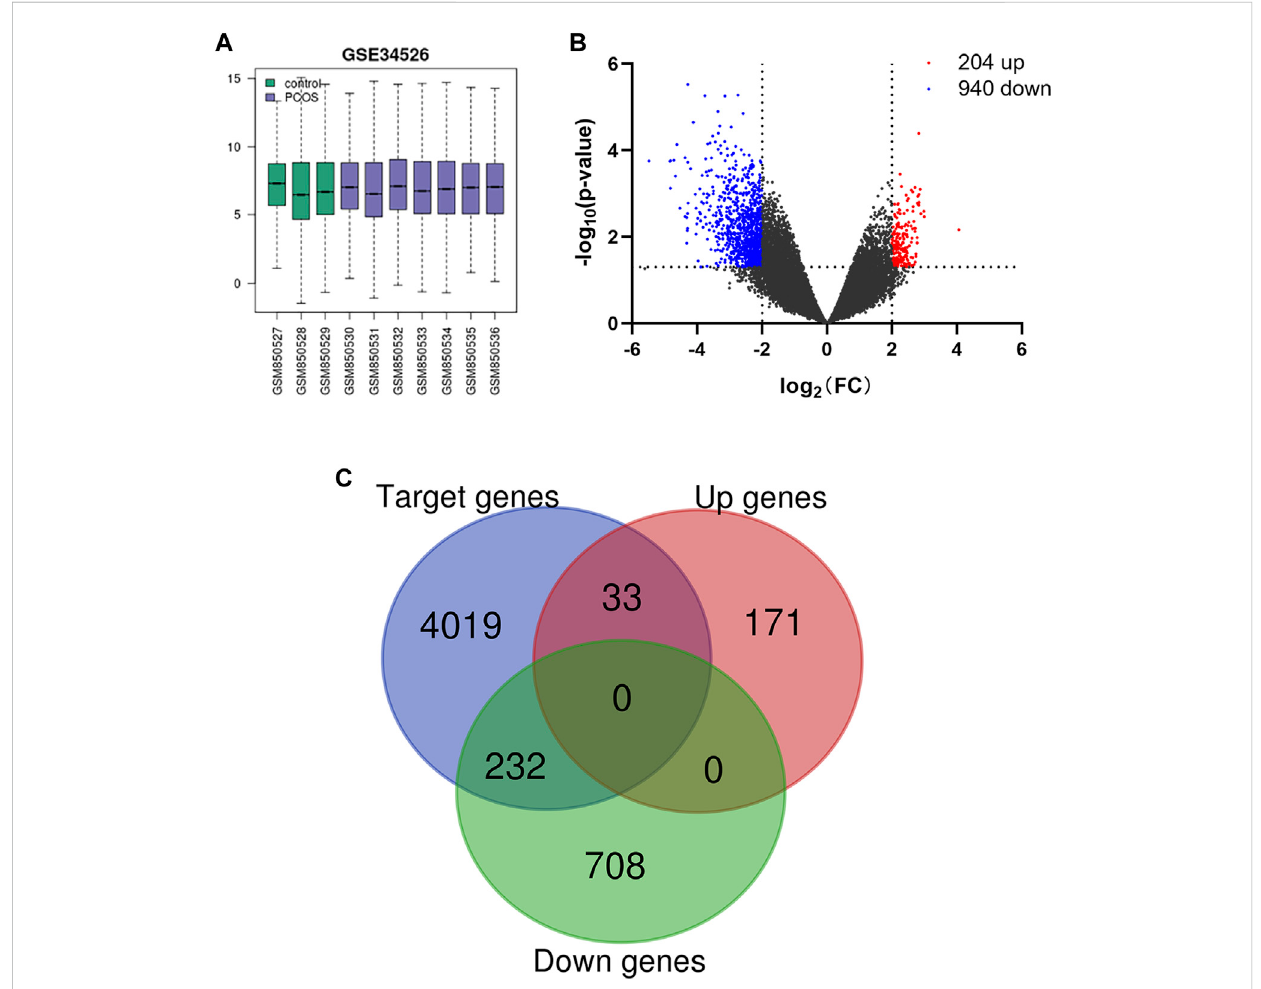
FIGURE 1 (A) Box plot of gene expression pro fi les after standardization. (B) Volcano plot of DEGs in PCOS. Red dots represent upregulation, blue dots represent downregulation, and gray dots represent no differential expression. (C) Venn diagram of DEGs and miRNA target